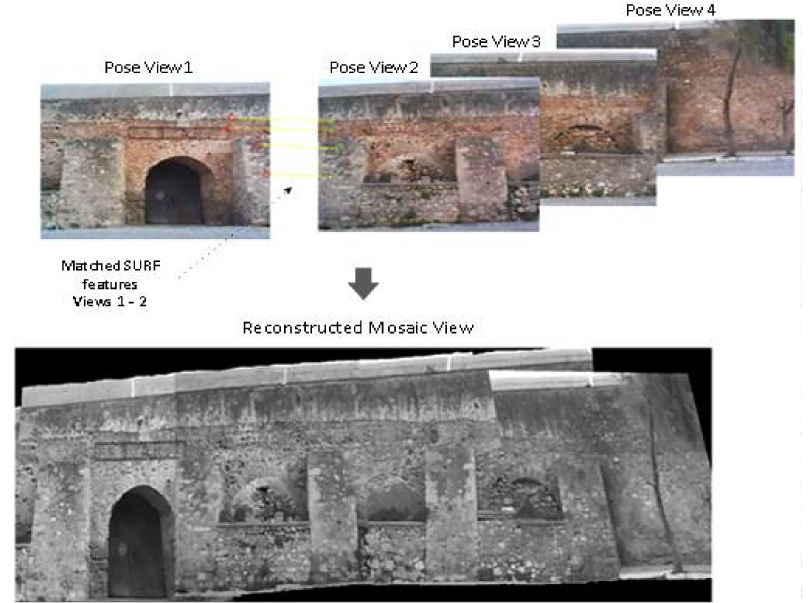
Figure 2. The mosaic view of the right side of Neoria, reconstructed for our case study, using a set of four viewing positions for the stereoscopic layout at specific viewing conditions (non-convergent layout, facing the building’s side) and a distance of approximately 8.5 m from the object/side of